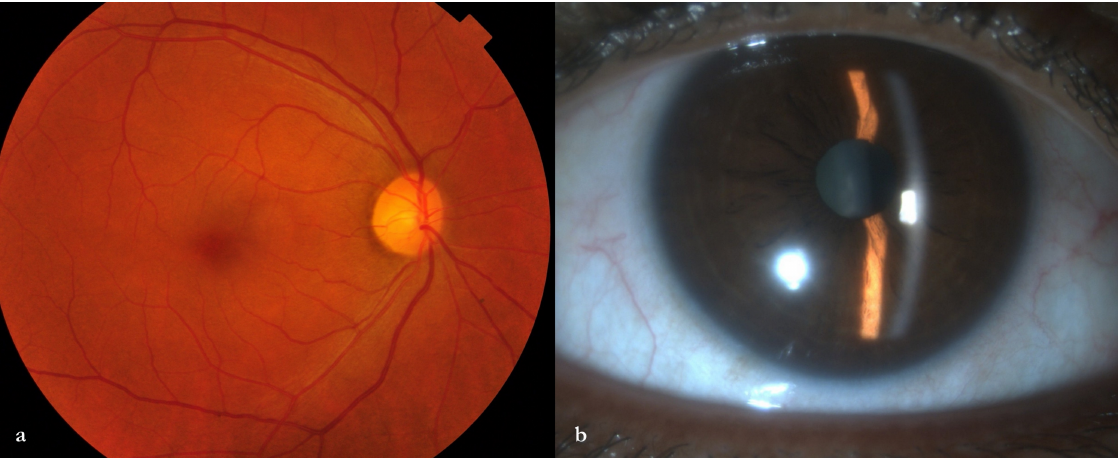
Figure 2: a) The color fundus photo shows resolved choroidal folds 1 month after presentation. b) The anterior chamber had deepened and the eye was quiet at 8-month